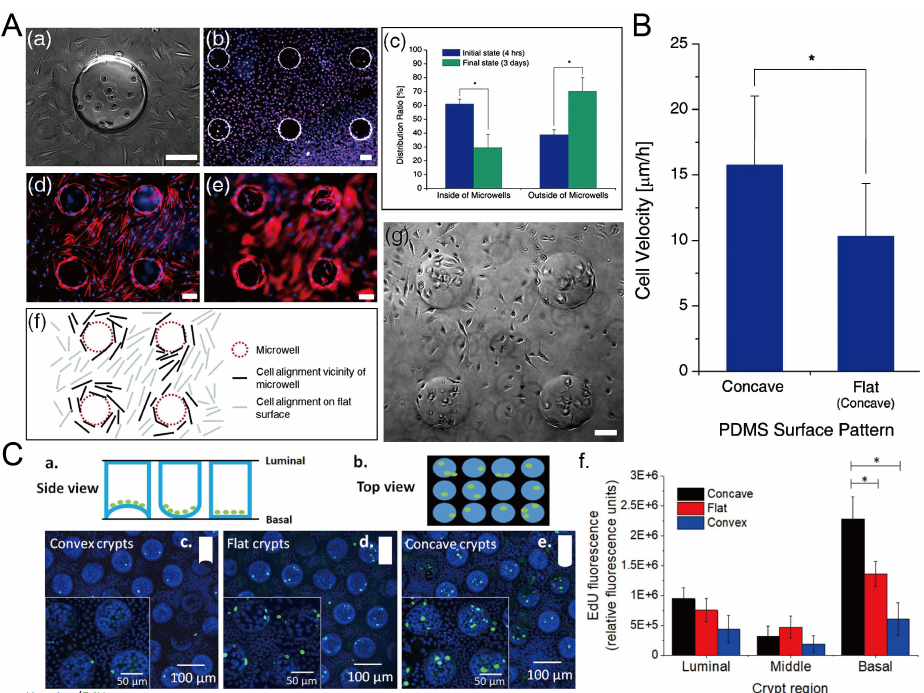
Figure 23. The behavior of cells in concave microwells. ( A ) 4 h after the seeding of L929 cells on the PDMS substrate with concave microwells (a), fluorescent images of L929 cells after three days of culture (b), the distribution of cells inside and outside of concave microwells in 4 h and 3 days after seeding (c), fluorescent images of human mesenchymal stem cells (hMSCs) cultured on PDMS substrate with concave microwells, of which the focus plane is on the flat plane (d) and concave microwells (e) respectively, the pattern of cells close to the microwells (f), and the status of L929 cells after three-day culture on the substrate with concave microwells (g) [69]. * p < 0.01. Scale bars: 100 µm. ( B ) Comparison of cell velocity on concave and flat surfaces [69]. ‘*’ indicates a significant difference ( p = 0.034). Reprinted (adapted) from [69]. Copyright (2009) with permission from Royal Society of Chemistry. ( C ) Schematic side view (a) and top view (b) of primary human colonic epithelial cell culture in microwells with different shapes, fluorescent images of cells cultured on different bases (c–e), and the comparison of 5-ethynyl-2 (cid:48) -deoxyuridine (EdU) fluorescence of cells cultured on different bases (f) [102]. * p < 0.001. Reprinted (adapted) from [102]. Copyright (2021) with permission from IOP